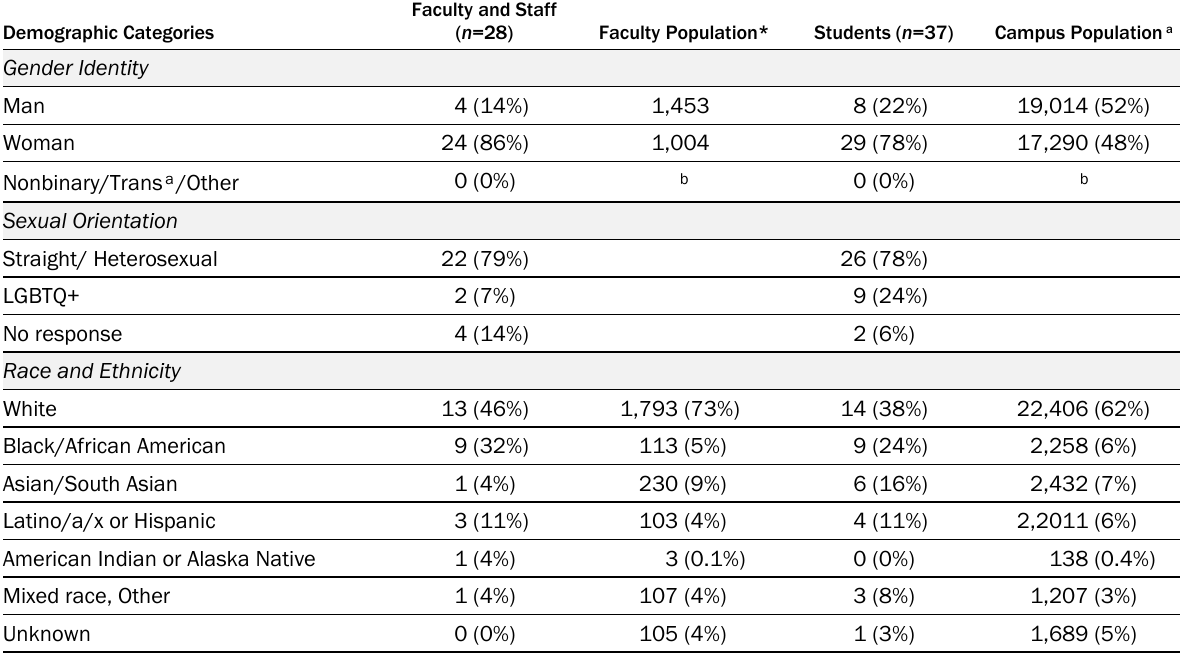
Table 1. Demographic Data of Workshop